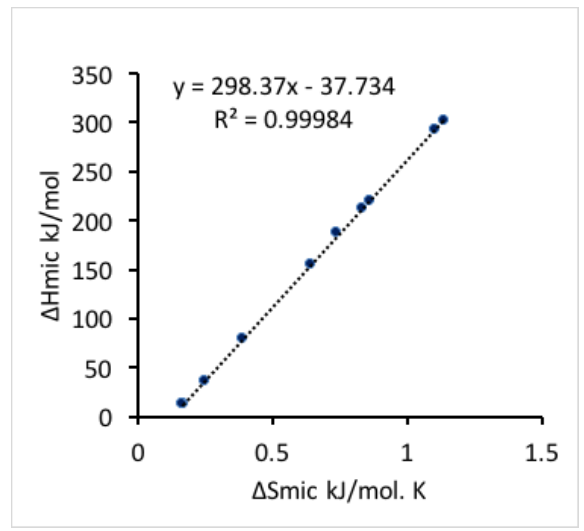
Figure 4. Enthalpy-entropy compensation of Pluronic P123 micellization process. The slope is defined as the compensation temperature (298.37 K) characterizing solvent-solute interaction.